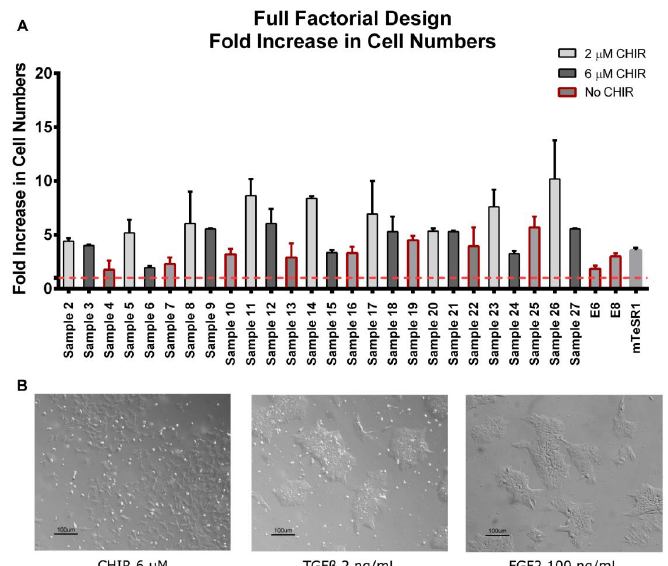
mesoderm and endoderm were calculated for each condition. Finally, (iv) scores obtained for each Bioengineering 2019 , 6 , x FOR PEER REVIEW condition were hierarchical clustered and fitted to full quadratic models for each score.